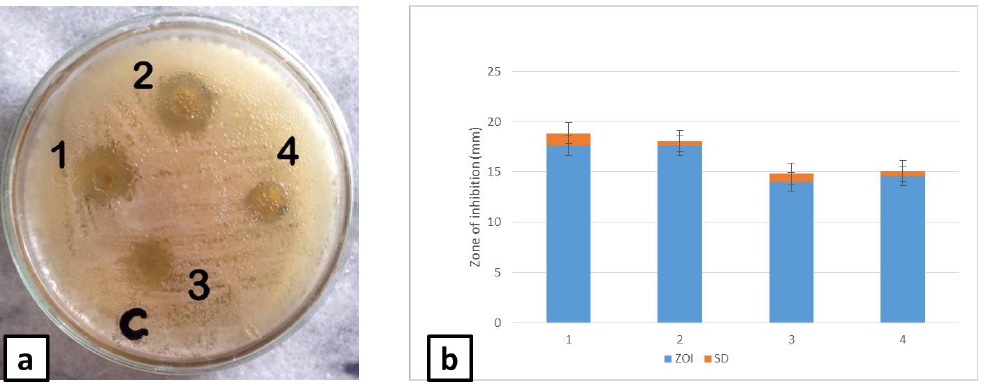
Figure 4. ( a ) Antifungal assay and ( b ) in vitro antifungal comparison of (1) nanolotion in DMSO, (2) nanolotion in water, (3) Quench cream, and (4) Dermazin cream.